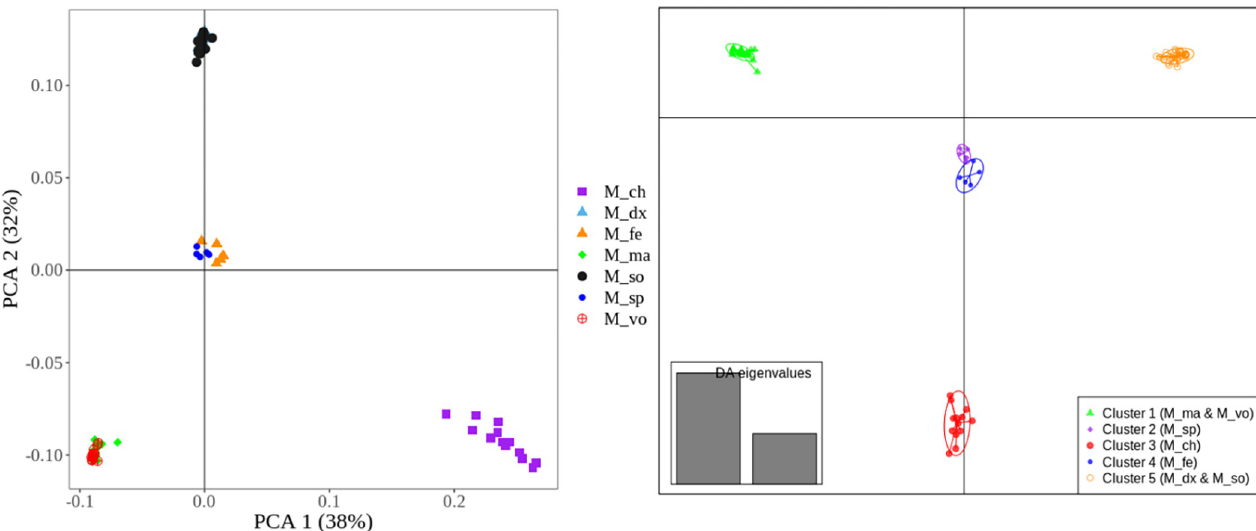
Fig 6. PCA (left plot) and DAPC (right plot) obtained from using the reduced set of ‘private SNPs’ (N = 72 SNPs, called ‘private SNPs80’ panel; see Methods). PCA–principal component analysis; DAPC–discriminant analysis of the principal components. M_ch–M . chevalieri; M_dx–M . dux; M_fe–M . felicinum; M_ma–M . macrobrachion; M_so–M . sollaudii; M_sp–M . sp; M_vo–M . vollenhovenii .